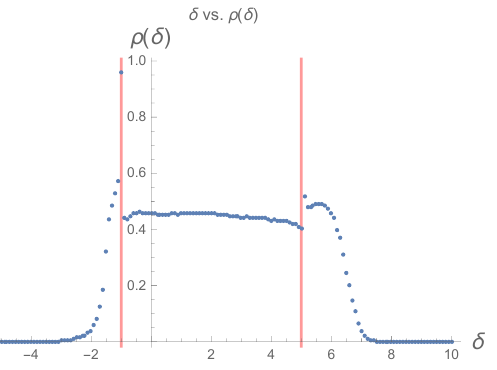
Figure 4 . The blue dots show the δ -dependence of the density ρ ( δ ) (see (3.8)). The red lines show the special values δ = − 1 , 5 . Here we also fix c = 30